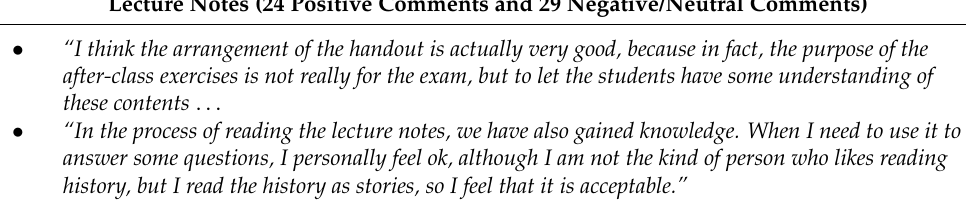
Table 3. Narratives of positive views on lecture notes and